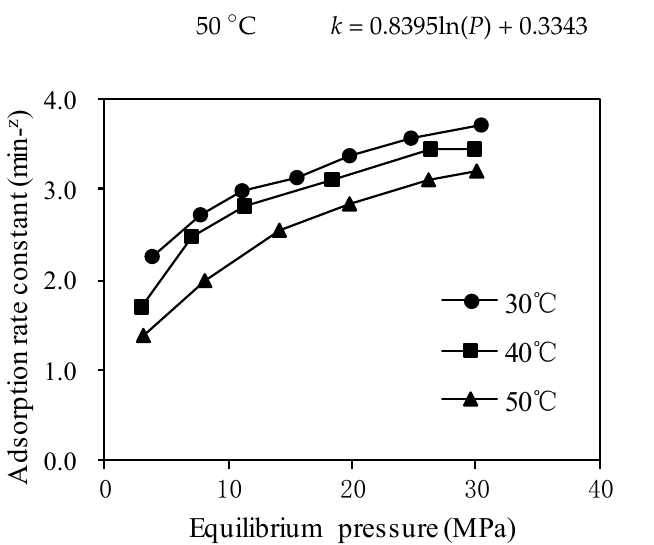
Figure 9. Adsorption rate constant versus equilibrium pressure at different temperature.